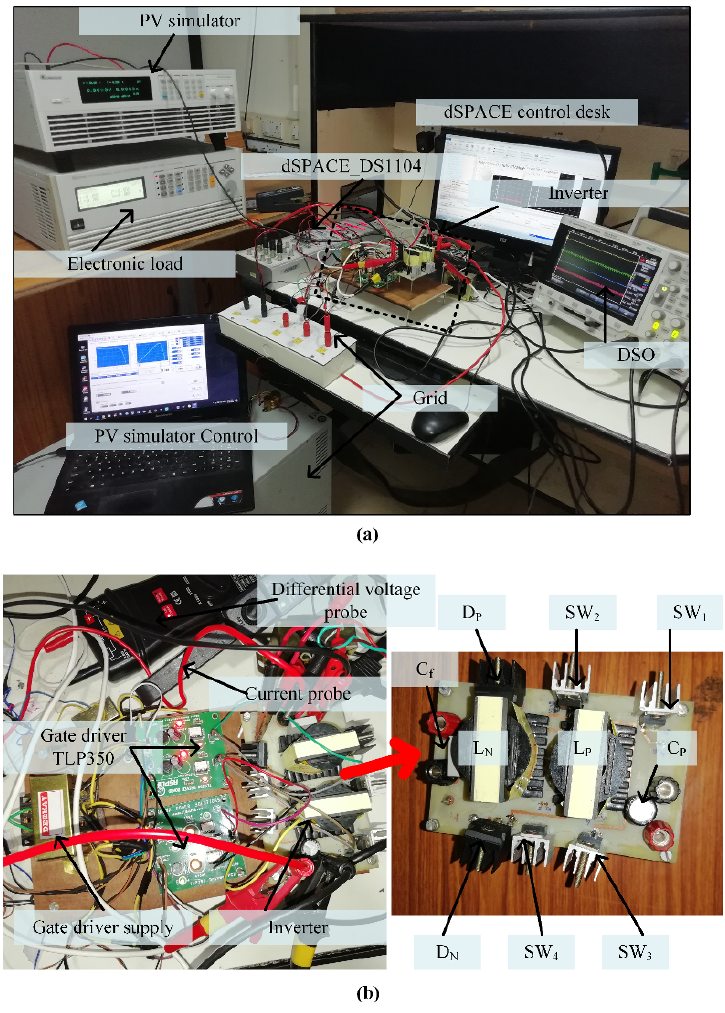
Figure 16. ( a ) Setup for the experiment. ( b ) Power circuit of